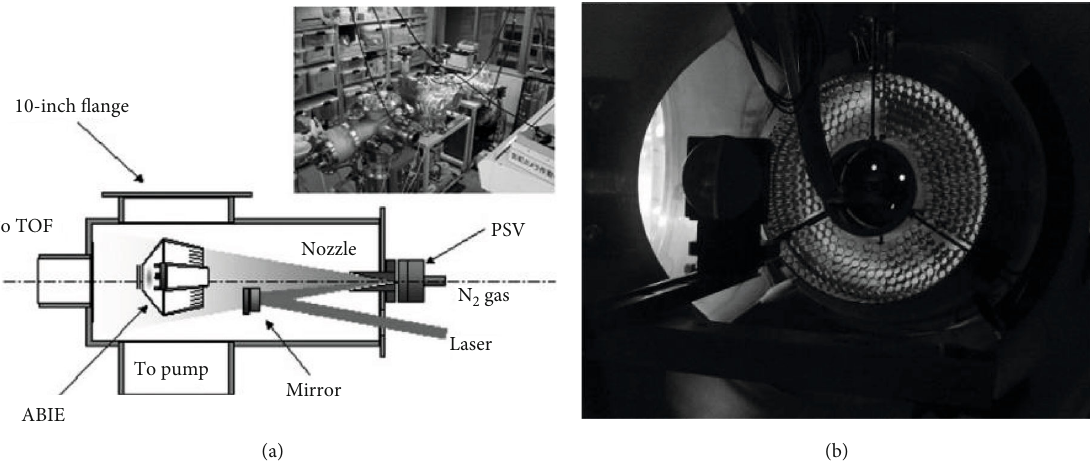
Figure 17: ABIE concept: (a) schematics and a photograph of the laser detonation atomic beam source; (b) photograph of oxygen plasma observed from the front side of the ABIE [48].